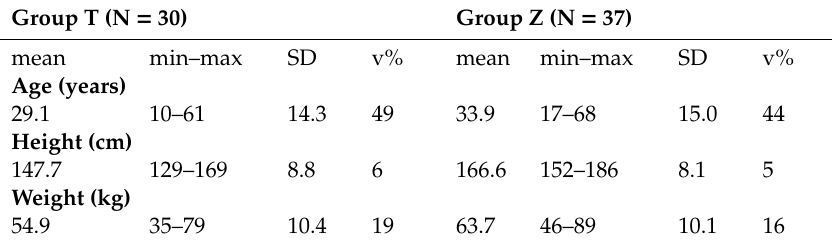
Table 1. Age and results of anthropometric measurements in studied groups.